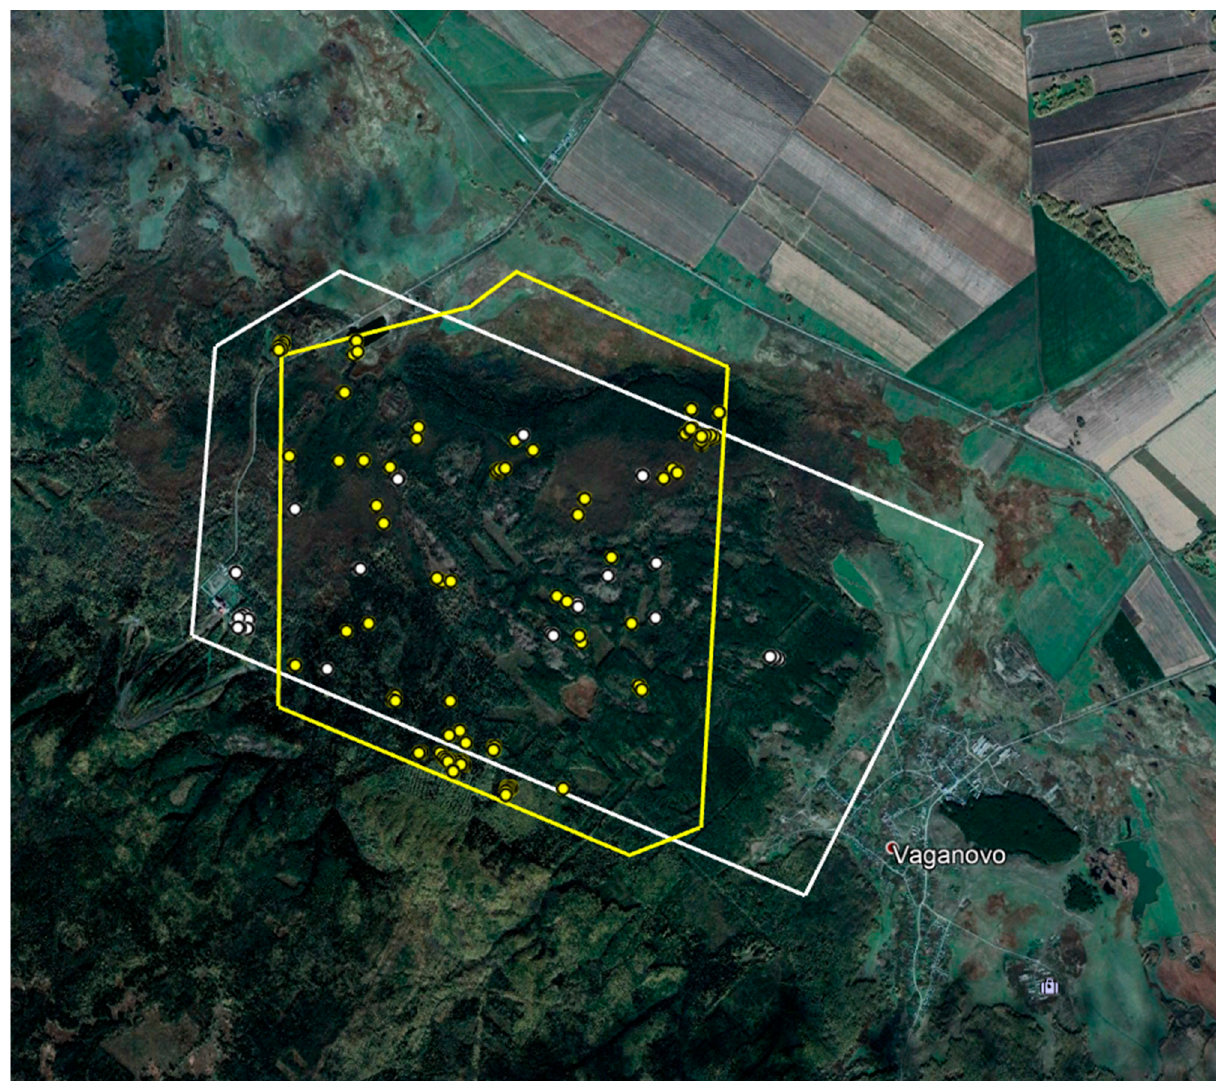
Figure 8. The area under survey and the distribution of elks in 2019 (white) 2020 (yellow).